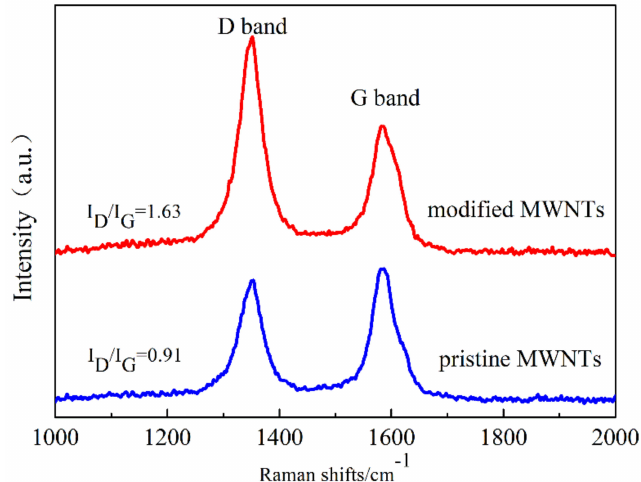
Figure 3. Raman spectra of pristine MWNTs and O 2 -plasma-modified